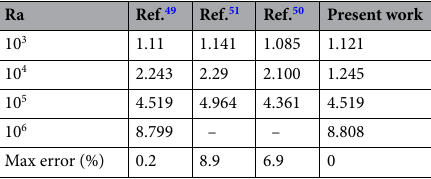
Table 2. Comparison of the Nusselt number in two-dimensional free convection resulting from the computer program and those of other works.